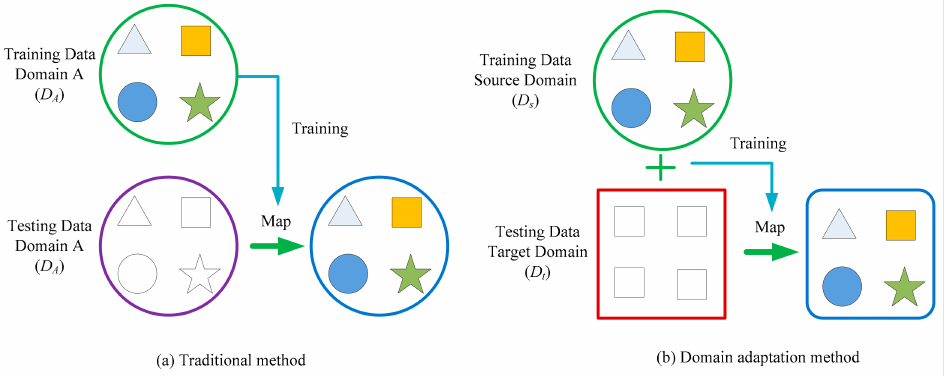
Figure 1. Intelligent learning system